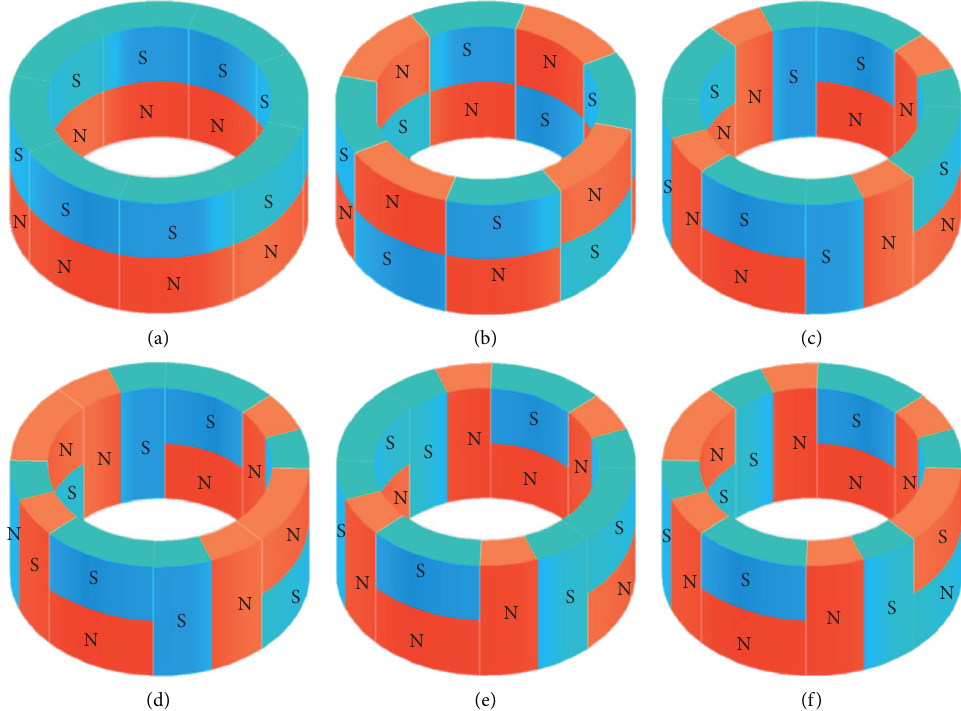
Figure 9: Magnetic circuit design scheme when the valve seat consists of eight identical shape tile magnets. (a) Scheme 10. (b) Scheme 11. (c) Scheme 12. (d) Scheme 13. (e) Scheme 14. (f) Scheme